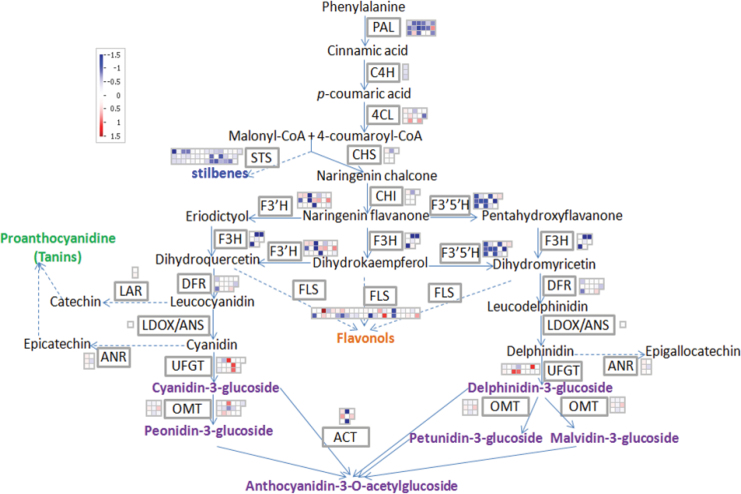
Effect of glucose concentration (468/58mM) in the culture medium on the expression of structural genes involved in anthocyanin biosynthesis in grape berries cultured in vitro. Expression data from the microarray were visualized using Mapman software. Genes involved in each metabolic step are located beside their encoded enzyme names. Relative expression levels calculated as log2 ratios (468mM/58mM) are represented as false colour with red for up-regulated genes and blue for down-regulated genes as illustrated in the colour key. Abbreviations: PAL, phenylalanine ammonia-lyase; C4H, cinnamate-4-hydroxylase; 4CL, 4-coumarate-CoA ligase; CHS, chalcone synthase; STS, stilbene synthase; CHI, chalcone isomerase; F3′H, flavonoid 3′-hydroxylase; F3H, flavonone 3-hydroxylase; F3′5′H, flavonoid 3′5′-hydroxylase; DFR, dihydroflavanol 4-reductase; FLS, flavonol synthase; LDOX/ANX, leucoanthocyanidin dioxygenase/anthocyanidin synthase; UFGT, UDP-glucose:anthocyanidin 3-O-glucosyltransferase; OMT, o-methyltransferase; ACT, anthocyanin acyltransferase; LAR, leucoanthocyanidin reductase; ANR, anthocyanidin reductase.